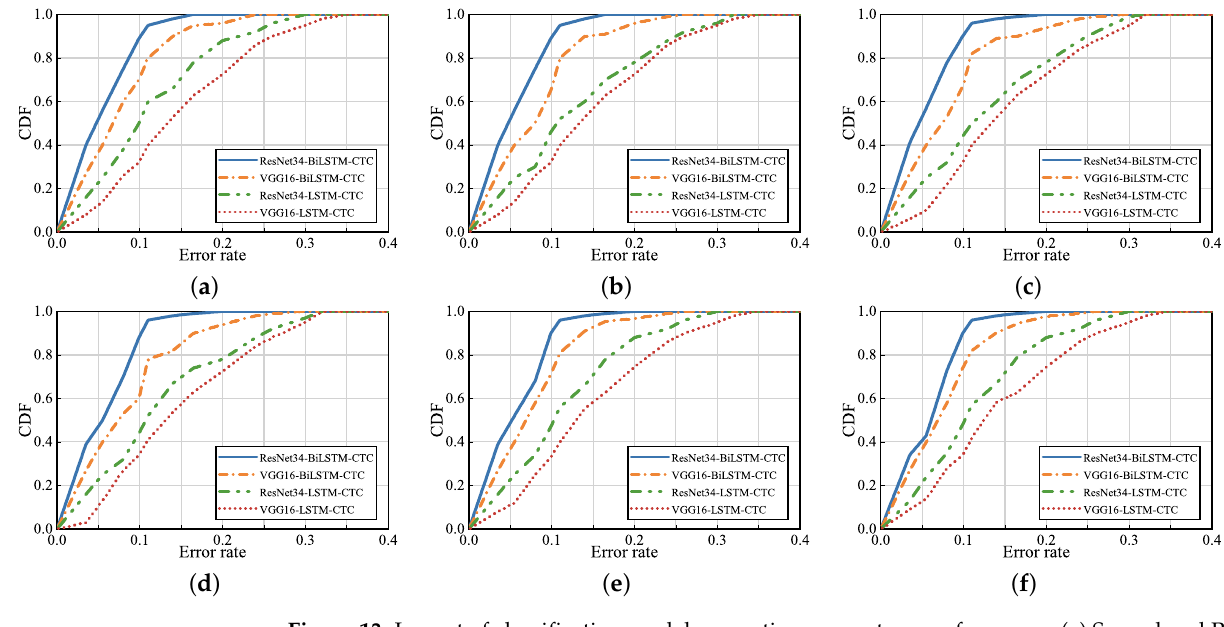
Figure 13. Impact of classification model on continuous gesture performance. ( a ) Spread and Pinch; ( b ) Push and Pull; ( c ) Hover and OK; ( d ) Around Left and Around Right; ( e ) One, Two, and Three; and ( f ) Slide Up, Slide Down, Slide Left, and Slide Right.